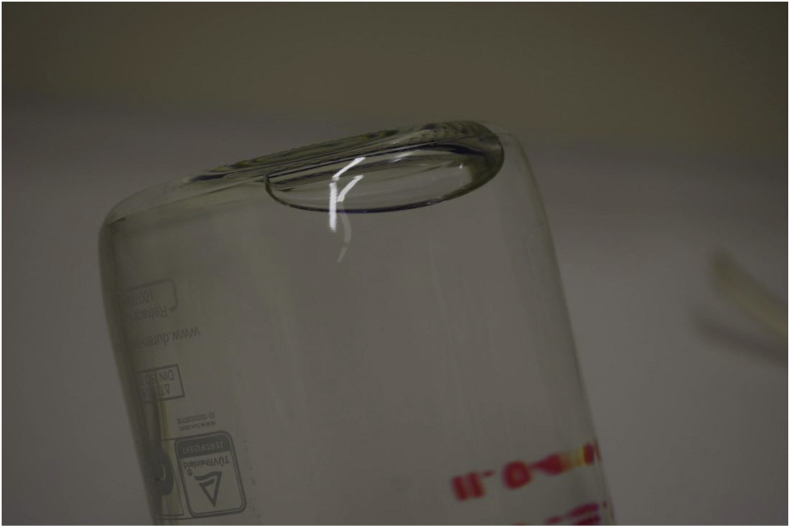
Bubble formation in the sampling bottle after cool storage of sample. Sampling bottle was turned upside down for the better visibility of produced bubble.